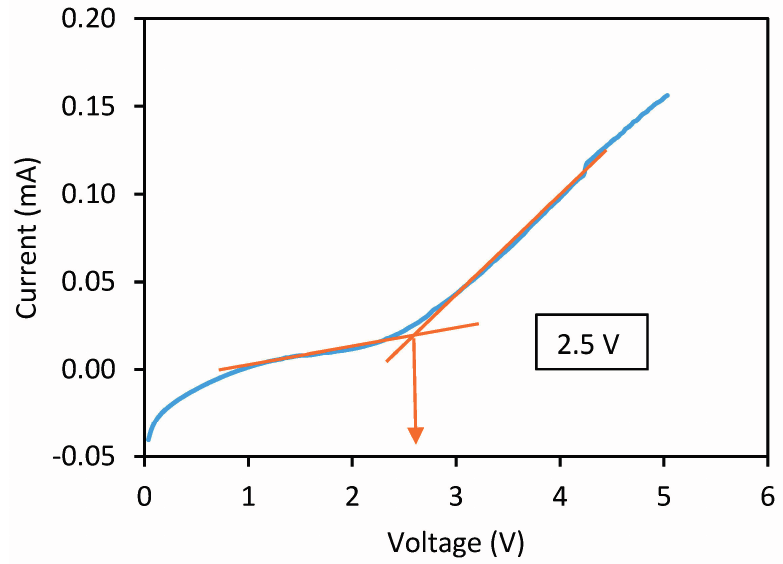
Figure 8. Current versus voltage plot of P(MMA- co -EMA) with the addition of 20 wt% NaI.